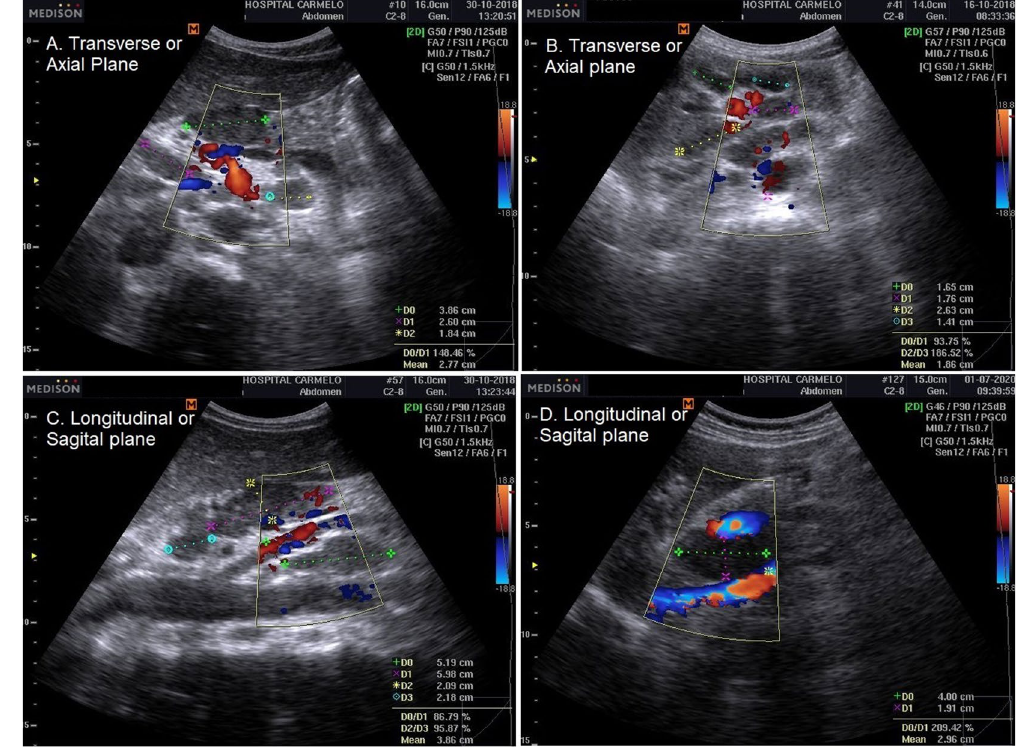
Figure 5. Intra-abdominal lymphadenitis TB: Conglomerate intra-abdominal (para-aortic, mesenteric) lymphadenopathy (lymph node enlargement greater than 1.5 cm; A – C ); large hypoechoic lesion compatible with retrohepatic abscess ( D